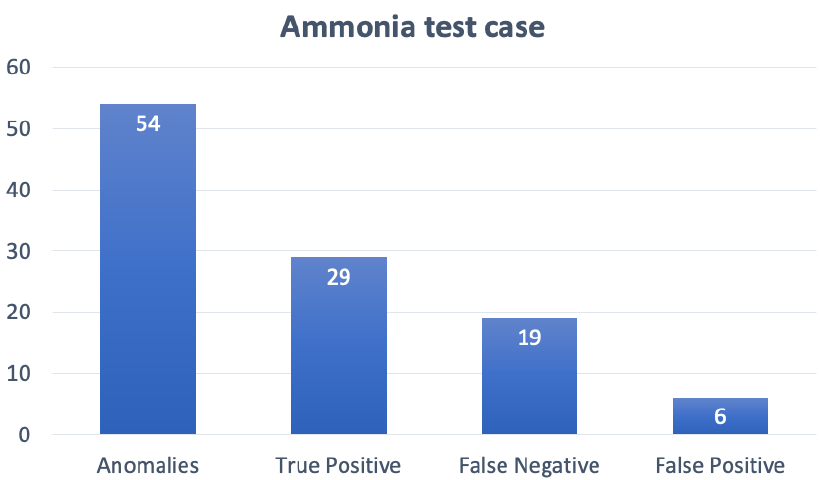
Figure 8. Anomalies related to the ammonia test case, as detected by the